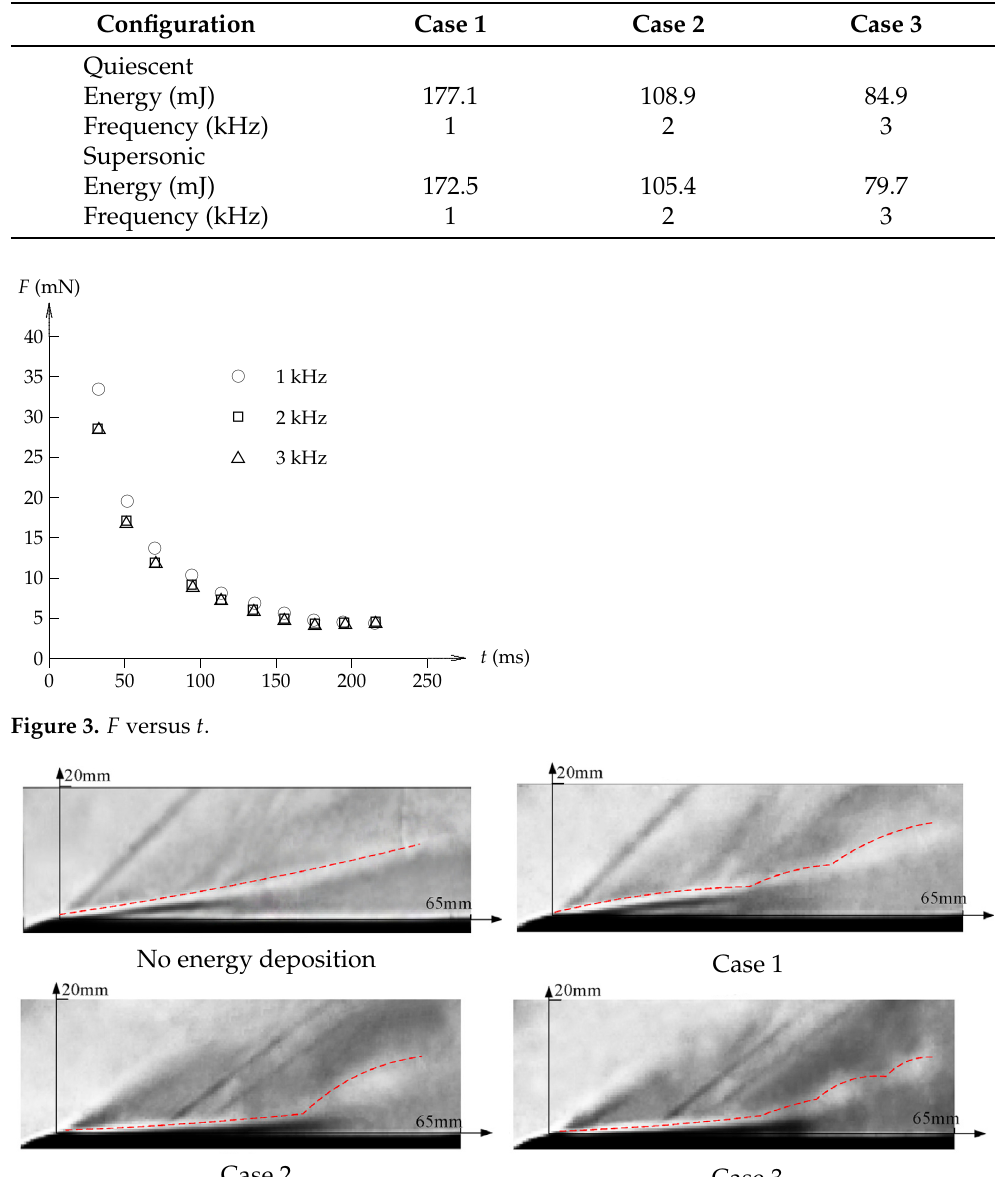
Figure 4. Time averaged Schlieren images. Reprint from [48] with permission from